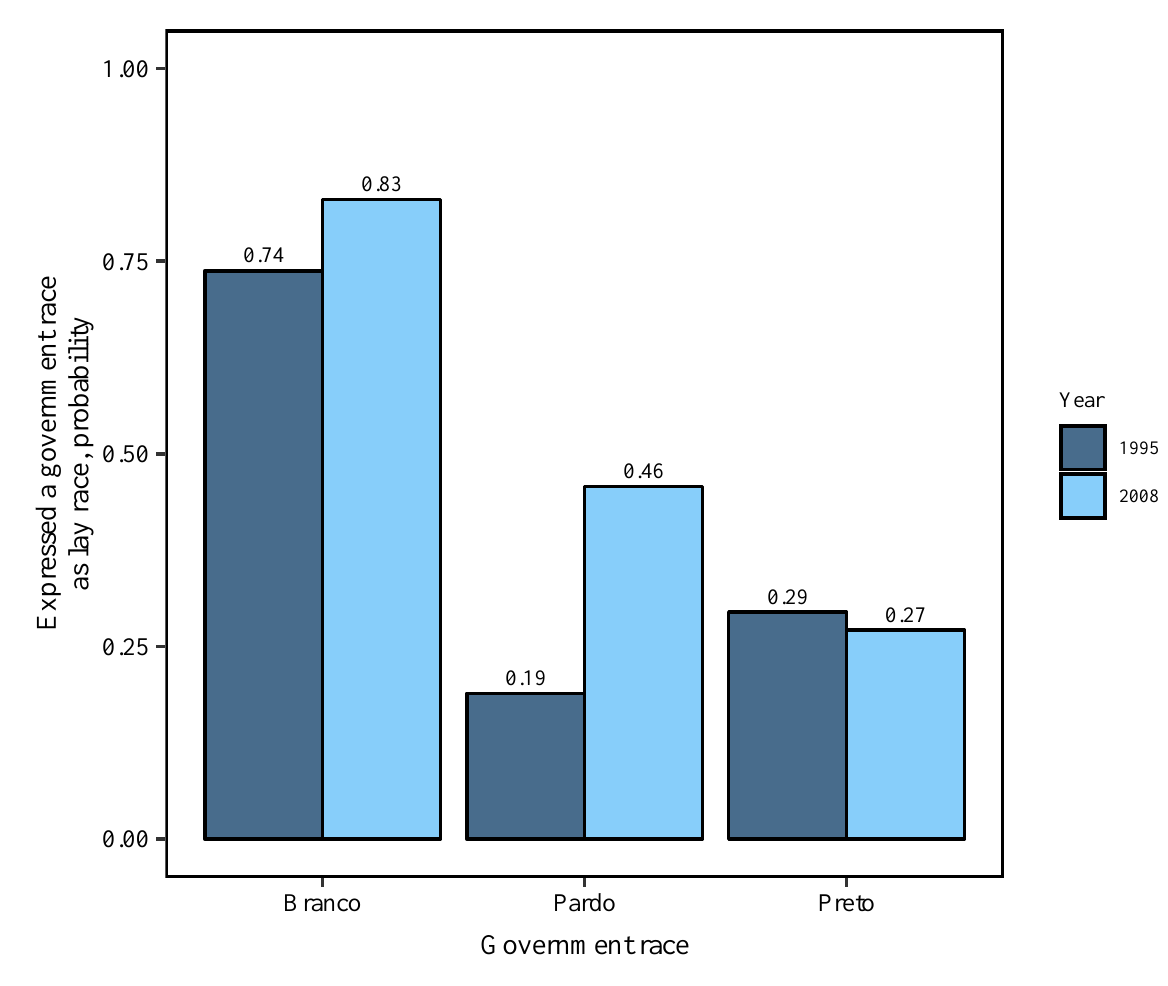
Figure 5: Average predicted probability for dimension alignment, 1995 and